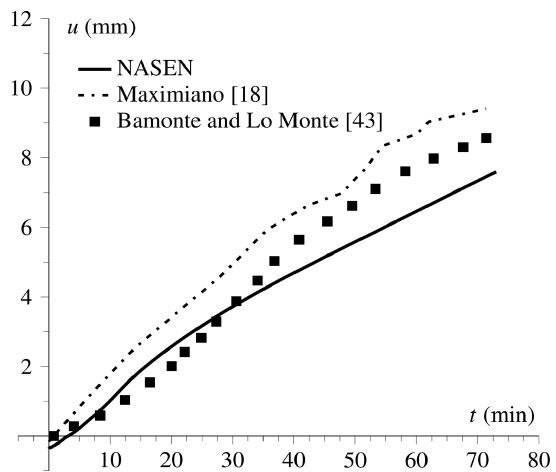
Figure 8. Evolution of axial displacement of the concrete column as a function of time of exposure to fire.